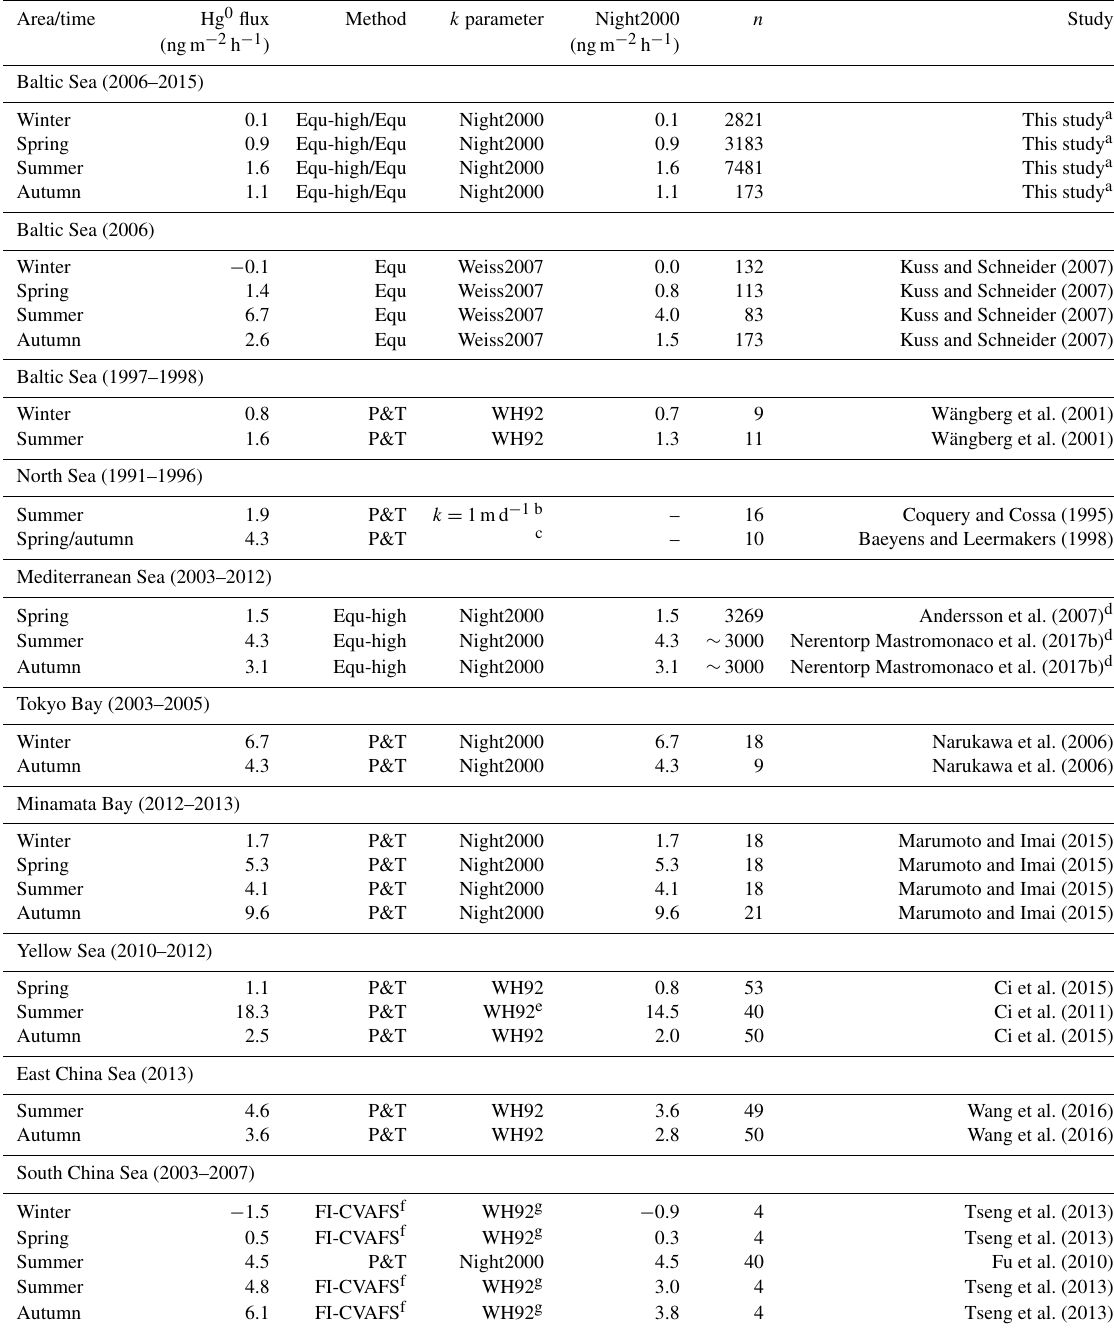
Table 4. Elemental mercury emission fluxes (in ngm − 2 h − 1 ) from selected marginal sea areas according to the season. The method used in data collection is shown as well: quantitative extraction of samples (P&T), equilibrator (Equ), or high-resolution equilibrator (Equ-high) mea- surements. Actual onboard measured wind speeds were used with the gas exchange model indicated: Night2000 (Nightingale et al., 2000), Weiss2007 (Weiss et al., 2007), WH92 (Wanninkhof, 1992), or other a , b . All fluxes were additionally recalculated to obtain rough estimates of the fluxes according to Night2000 (see